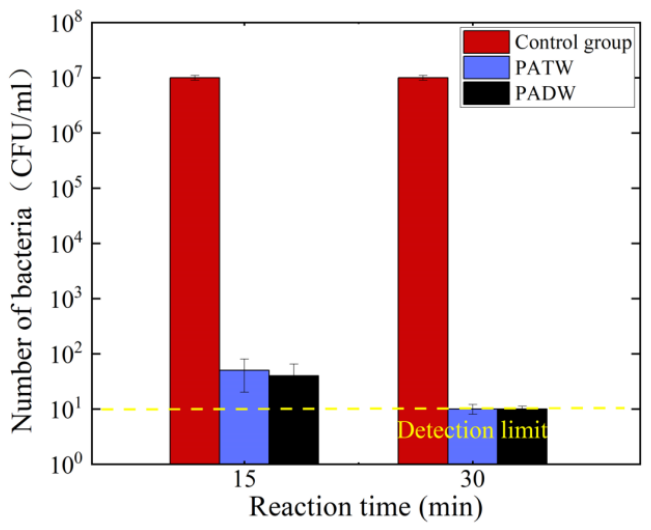
Figure 10. Comparison of the number of surviving E. coli after PATW and PADW treatment.